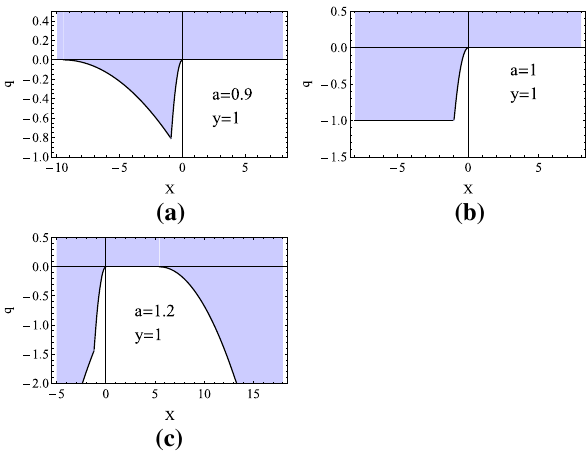
Fig. 3 The allowed region in the constant of the motion plane ( X − q ) depicted for some representative values of spacetime parameters a , y , successively corresponding to cases y < 1 / a 2 , y = 1 / a 2 , y > 1 / a 2 . An intersections of a line q = const. < 0 with the border curves q 1 ( X